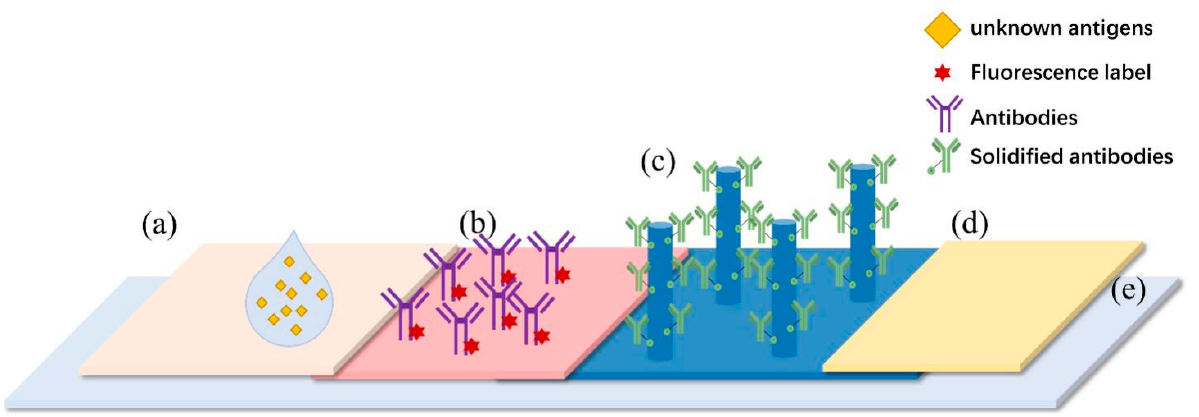
Figure 4. Design of microfluidic sensor based on the nanoforest structure. ( a ) Sample pad. ( b ) Conjugate pad. ( c ) Detection area containing the corresponding capture antibody with nanoforest. ( d ) Absorbent pad. ( e ) The backing plate.